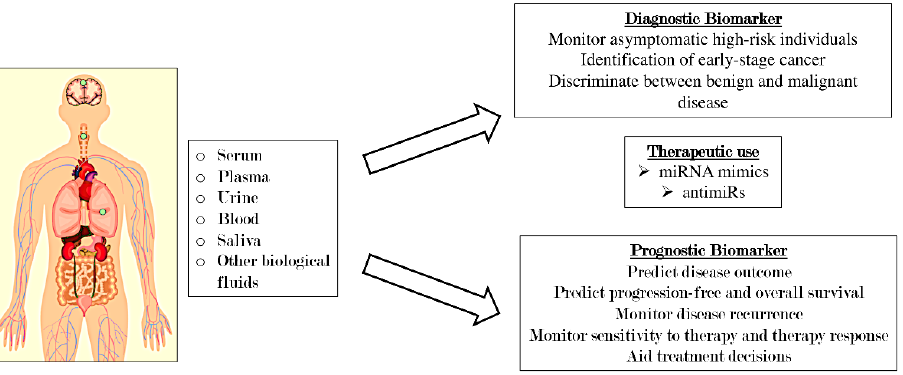
Figure 2. Promising clinical values of miR-19a for early cancer diagnosis, treatment, and progno- sis.